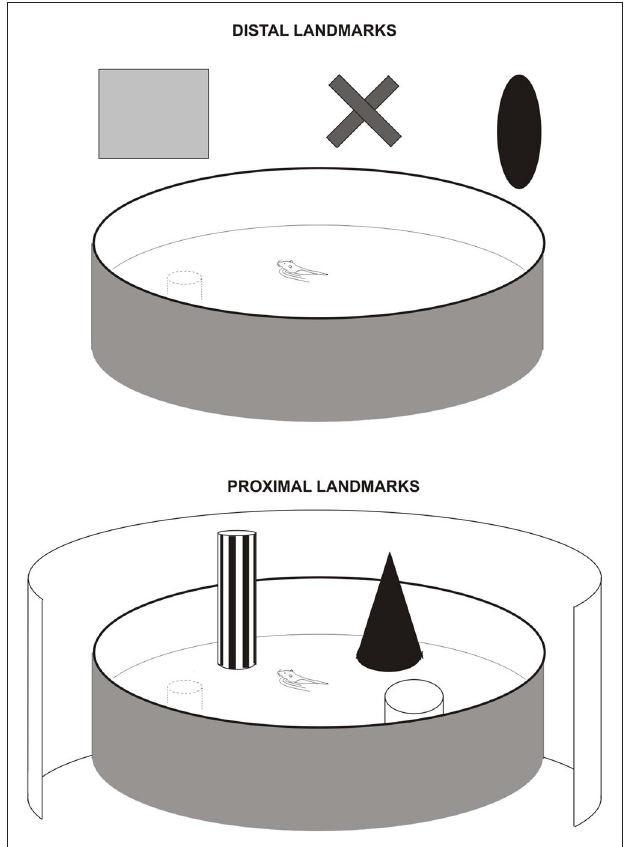
FIGURE 1 | Navigation task in the water maze with distal landmarks (upper figure) or proximal landmarks (lower figure) used by Save and Poucet (2000) and Parron et al. (2004). In the distal cue condition, all room cues were available. In the proximal condition, the pool was surrounded by an opaque curtain to mask room cues. The proximal landmarks were three distinct objects placed in the water near the